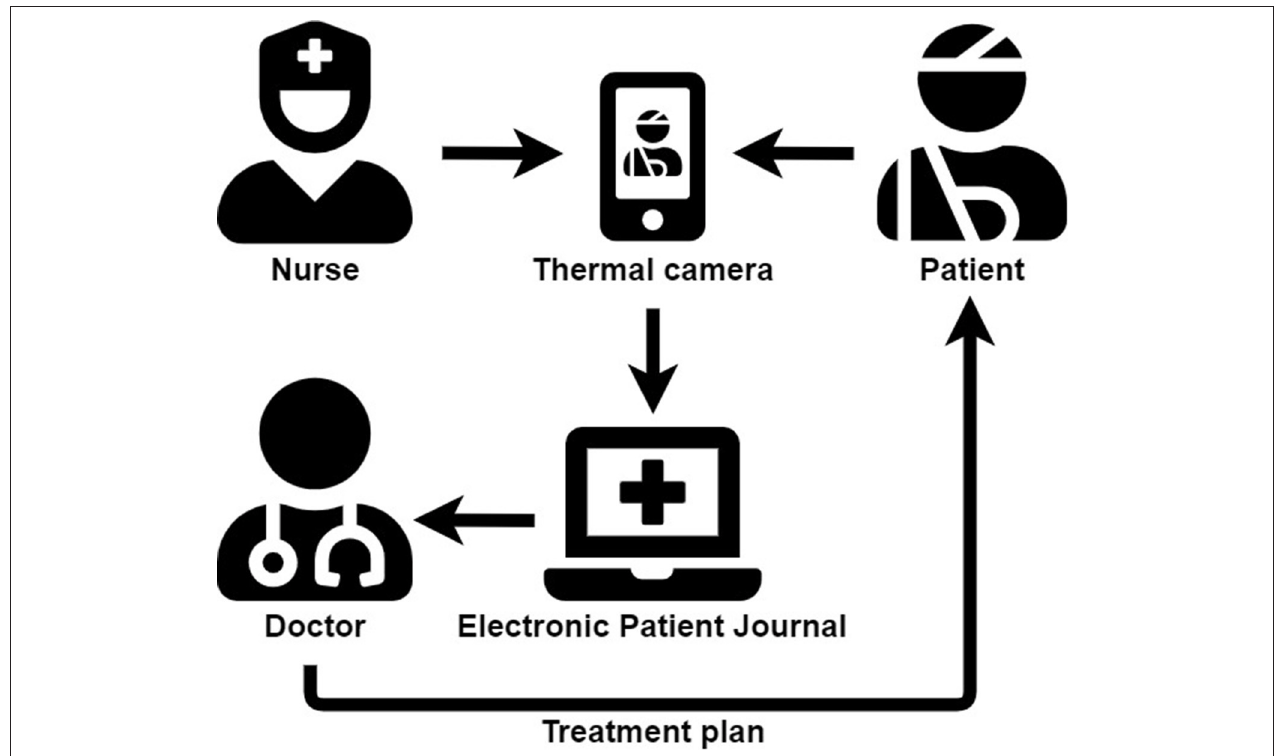
FIGURE 2 | Overview of the proposed solution. Source: